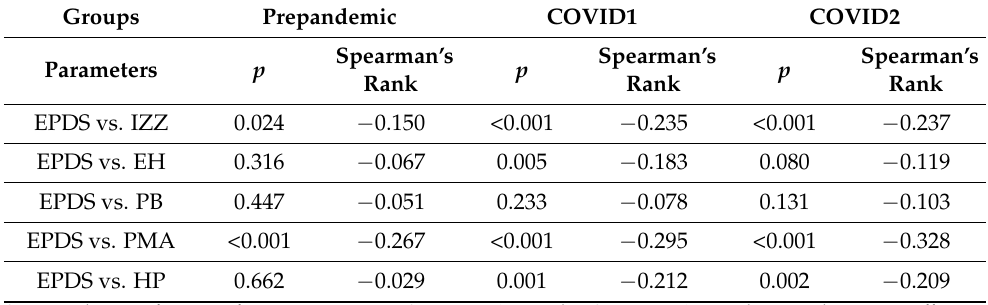
Table A2. Spearman’s Rank Correlations between depressive disorders and health behaviors. Groups